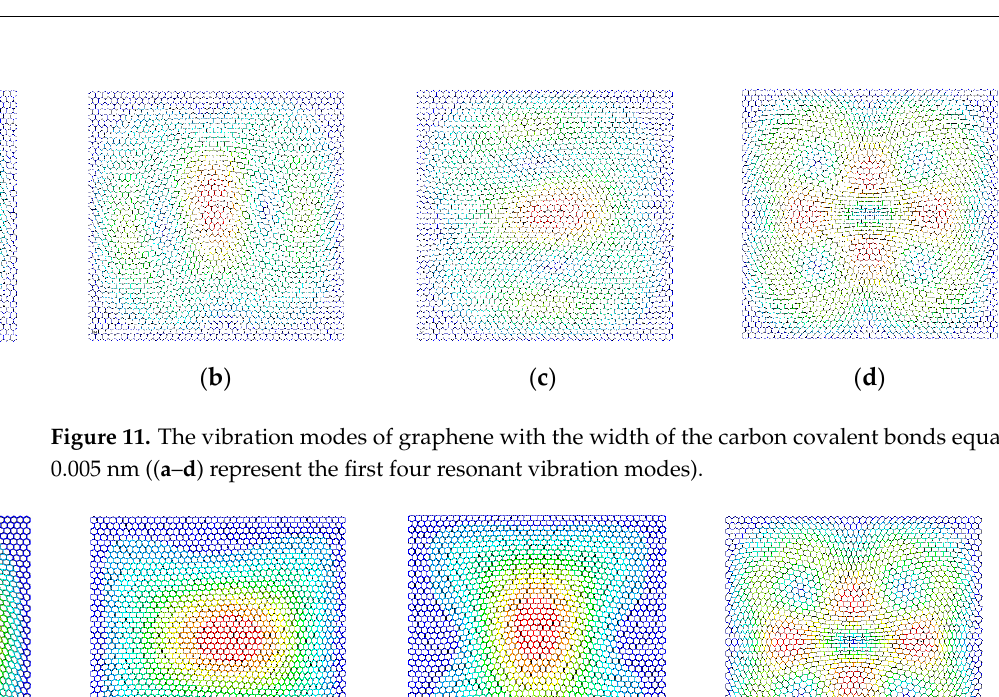
Figure 10. The vibration modes of graphene with the length of the carbon covalent bonds equal to 0.4 nm (( a – d ) represent the first four resonant vibration modes).